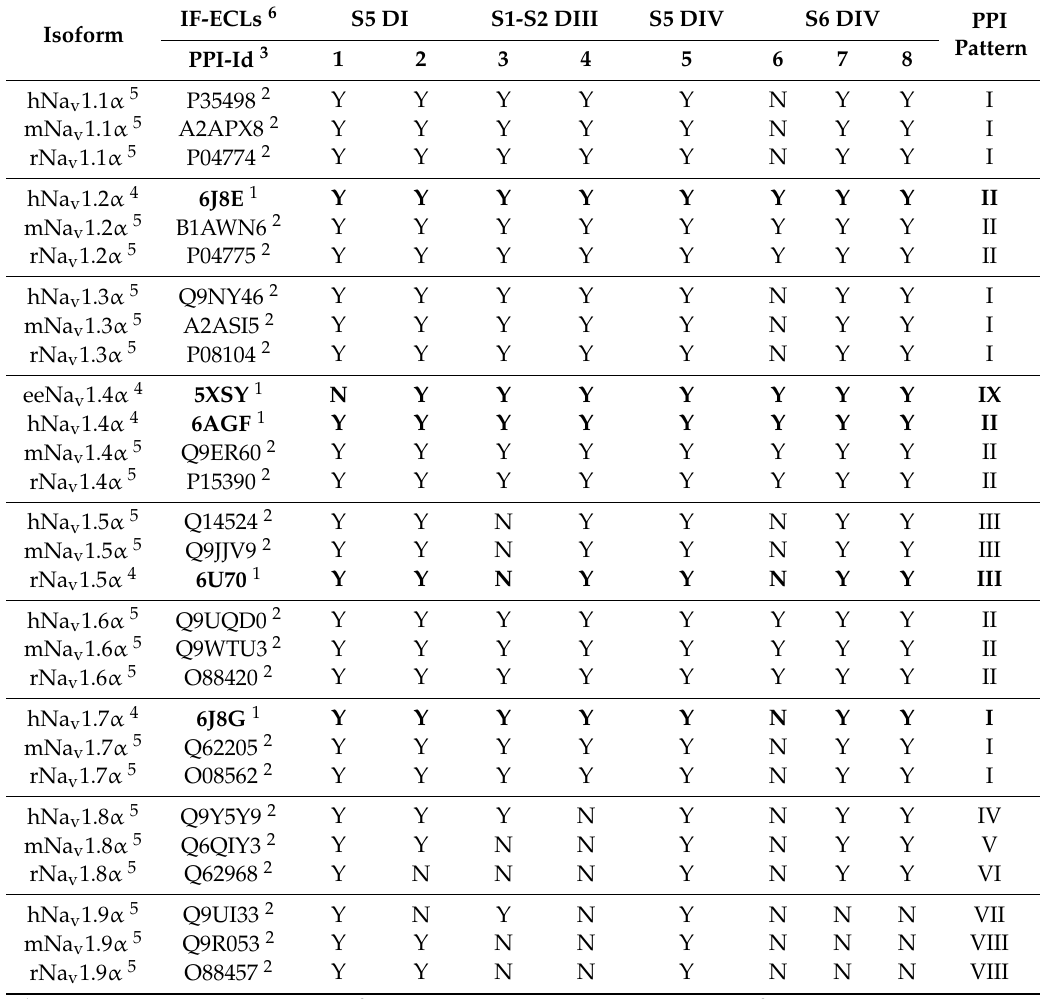
Table 1. Synopsis of the studied PPI patterns. The interaction sites are labeled as PPI-Id with Arabic numerals from “1” to “8” to identify them. The resulting patterns are labeled with Roman numerals from “I” to “IX”. Certain PPI between Na v α / Na v β 1 and Na v α / Na v β 3 have been observed experimentally by structure elucidation. Their respective PDB entries and PPI-Id values are marked in bold face. They were used as templates for the reminder. The Y / N values in the table cells symbolize YES / NO referring to the presence / absence of contributions to